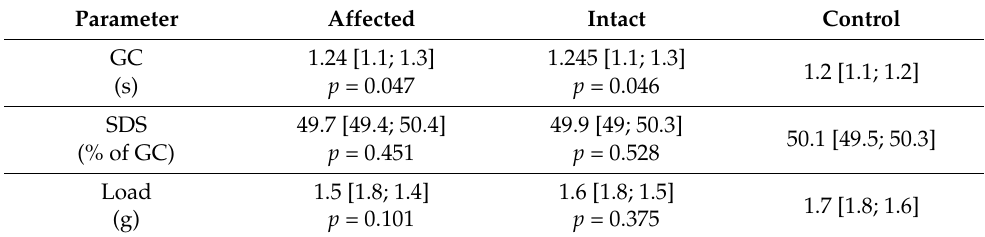
Table 2. Temporal parameters of gait cycle and impact amplitude at the start of the stance phase.